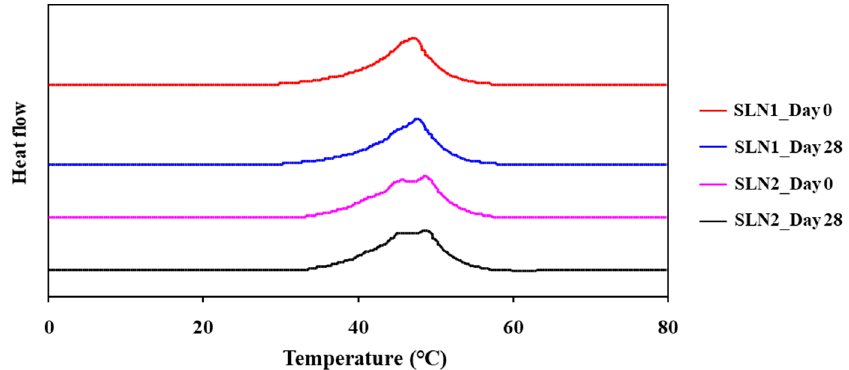
Figure 4. DSC heating curves of SLN dispersion for long-term storage.